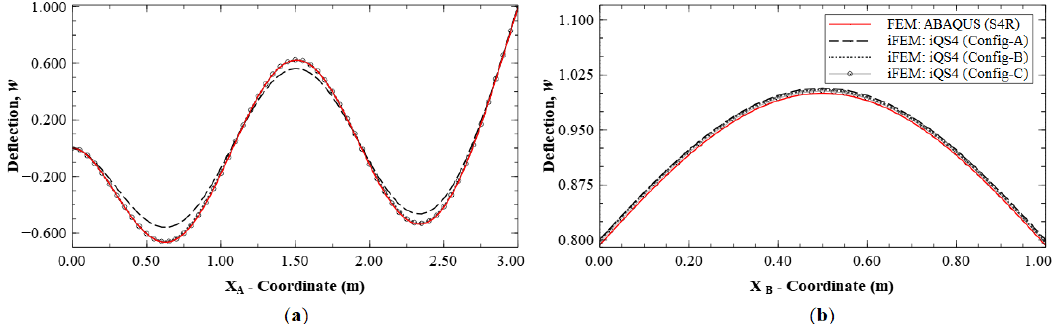
Figure 12. Line plots of deflection ( w ) for Mode 6 along: ( a ) section A-A’; and ( b ) section B-B’; (see Figure 5b for the section definitions).